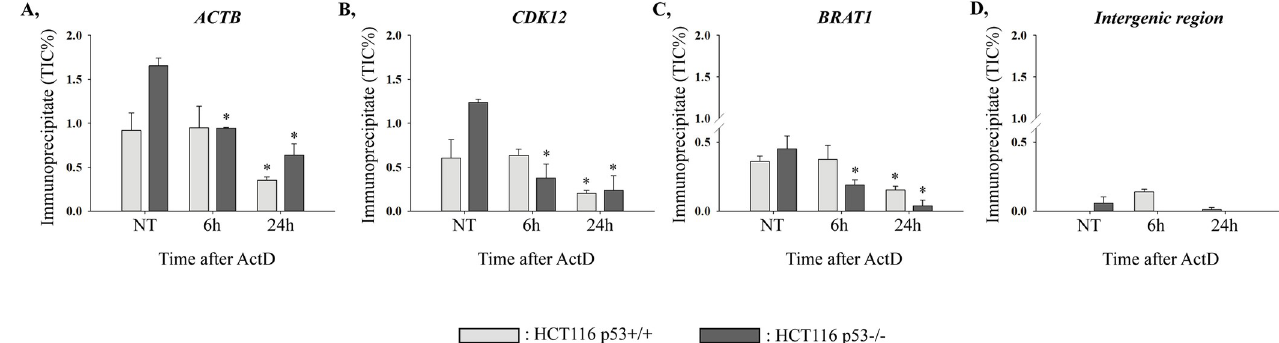
Fig 1. p53 affects the profile changes of elongating RNA polymerase II (S2P RNAPII) at transcriptionally active gene regions following Actinomycin D (ActD)-induced transcription elongation block. ( A–C ) S2P RNAPII occupancy was monitored with ChIP–qPCR at ACTB , CDK12 , and BRAT1 gene bodies in the presence (light grey columns; HCT116 p53+/+ cell line) and in the absence (dark grey columns; HCT116 p53-/- cell line) of p53. The profile changes were tracked under physiological conditions (NT) as well as following 6 h and 24 h ActD treatments. ( D ) Primers designed to an intergenic region were used as the negative control of the ChIP. The figure shows the representative result of one out of two independent experimental replicates. qPCR reactions were performed in duplicates. Asterisks represent statistical significance ( � P � 0.05) between the mean values. Mean values of ActD-treated samples were compared to the mean value of the corresponding non-treated sample by one-way ANOVA in case of each cell line.